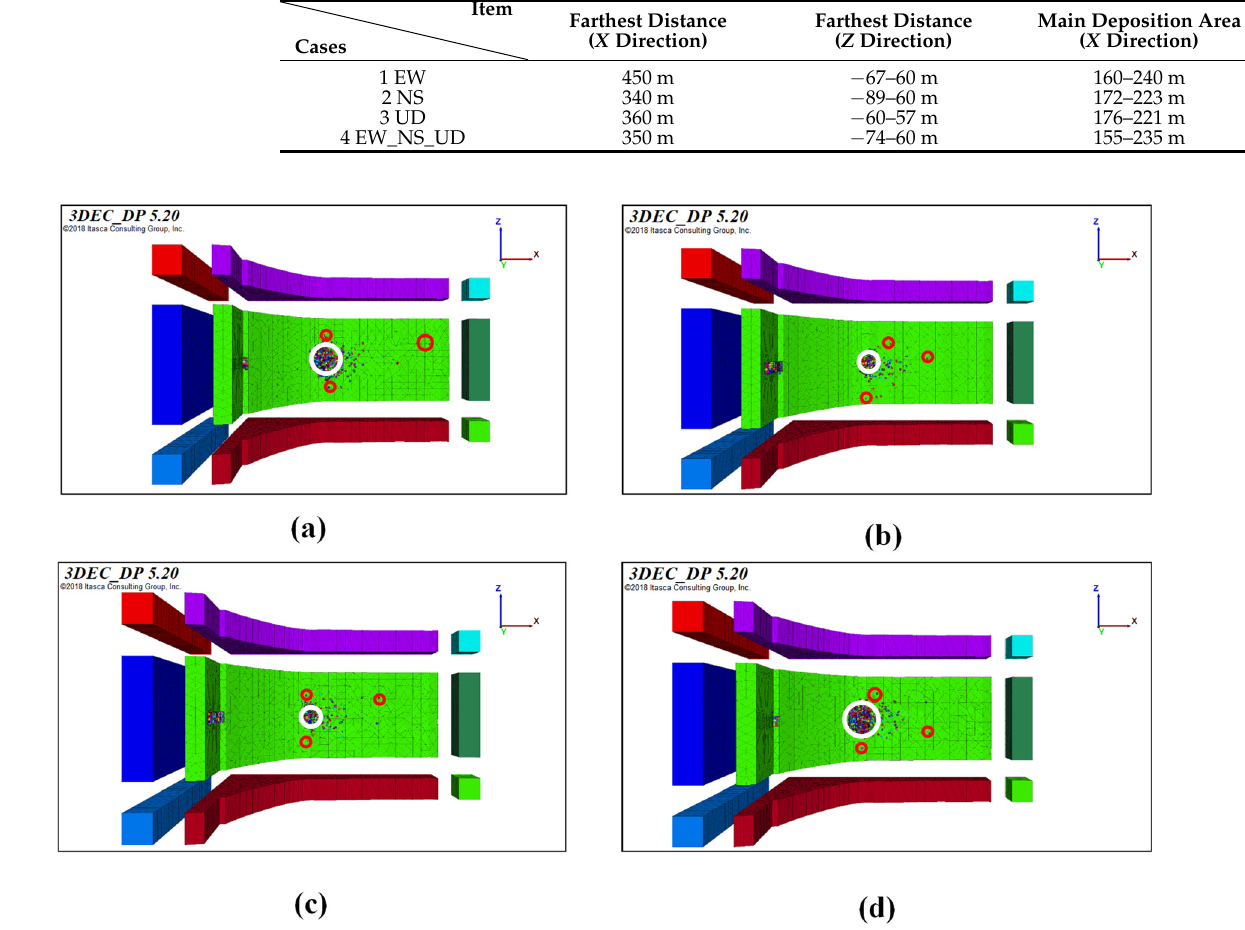
Figure 19. Deposition of high-steep rock slide in four cases (the three red circles in the figure represent the most distal, leftmost, and rightmost blocks, respectively, and the white circles are the main rock slide deposition). ( a ) Case 1: EW seismic wave; ( b ) case 2: NS seismic wave; ( c ) case 3: UD seismic wave; and ( d ) case 4: EW_NS_UD seismic wave.